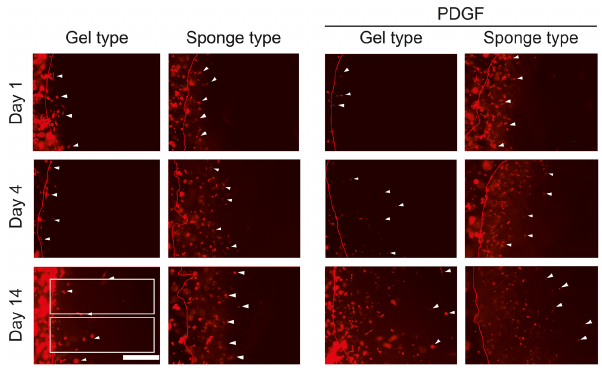
Figure 2. Fluorescence images of human gingival fibroblasts populating the gel type and the sponge type scaffolds. Fluorescence microscopy shows DiI-labeled human gingival fibroblasts populating the gel type and the sponge type scaffolds. Images from days 1, 4, and 14 are shown. White arrows indicate the cells at the migration front. The border of the scaffoldss is indicated by a red line. The white boxes show the regions of interest (0.75 mm 2 ), starting at the border of the scaffolds, where quantification of cell numbers and migration distance was performed. The region was 0.5 mm high and 1.5 mm wide. The photos were colorized using Adobe Illustrator. The white bar represents 500 m m.